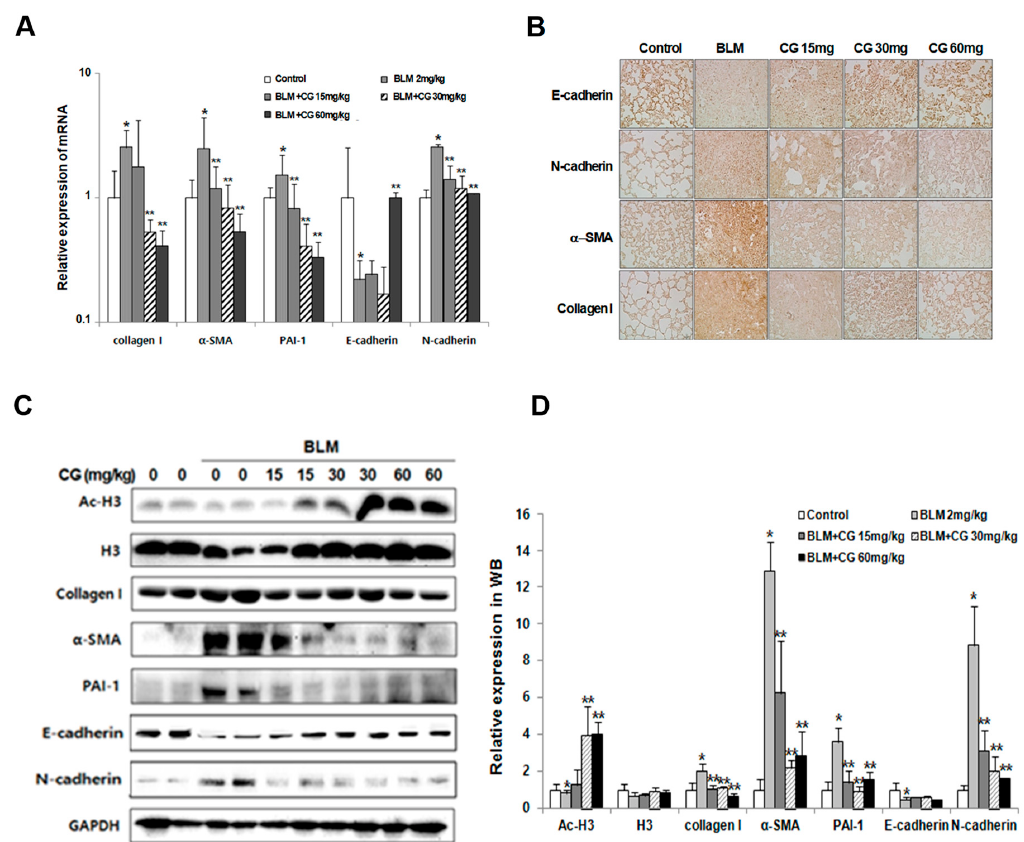
Figure 3. Effects of CG-745 on bleomycin-induced epithelial-mesenchymal transition and fibrosis of mice. ( A ) The mRNA (messenger RNA) levels of fibrotic marker (collagen I, α -SMA, PAI-1) and EMT (Epithelial-Mesenchymal Transition) marker (E-cadherin, N-cadherin) expressions in the lung tissues were analyzed by real-time qPCR. Gene expression was presented as fold changes and normalized to GAPDH (Glyceraldehyde-3-Phosphate Dehydrogenase). ( B ) Representative immunohistochemical staining of α -SMA, collagen I, E-cadherin and N-cadherin in mice (magnification, ×200). ( C ) The protein levels of fibrotic marker (collagen I, α -SMA, PAI-1) and EMT marker (E-cadherin, N-cadherin), H3 (histone H3) and Ac-H3 (acetylated histone H3) in the lung tissues were analyzed by western blotting. Immunoblots are representative of at least three independent experiments. (D) The bar graphs for an average (n = 15/group) shows for providing a quantitative data. Data are presented as mean ± SD, n = 5. * p < 0.01 versus control group. ** p < 0.05 versus bleomycin group.